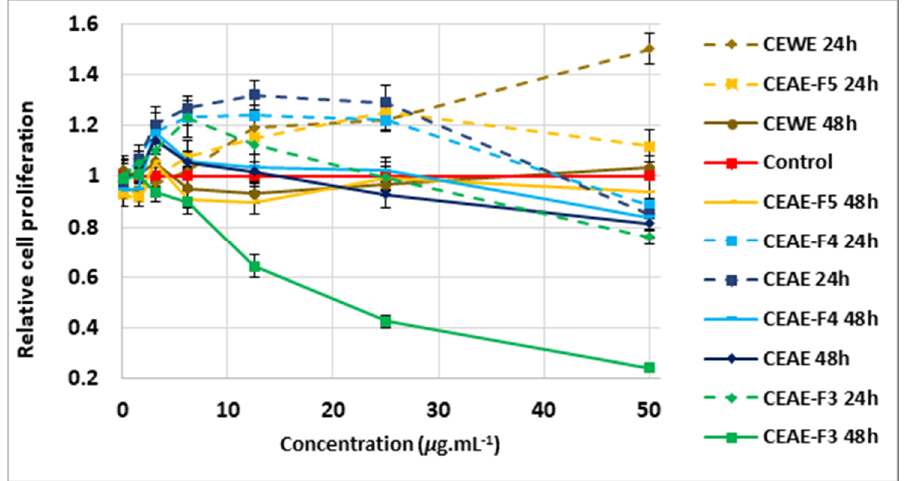
Figure 5. Cell-proliferating effect of C. inophyllum extracts, CEWE and CEAE, and resulting fractions CEAE-F3, CEAE-F4 and CEAE-F5 after 24 h and 48 h of treatment of dermal papilla cells at concentrations 0.1 to 50 µg.mL −1 normalized and compared to the control. Error bars represent SEM.